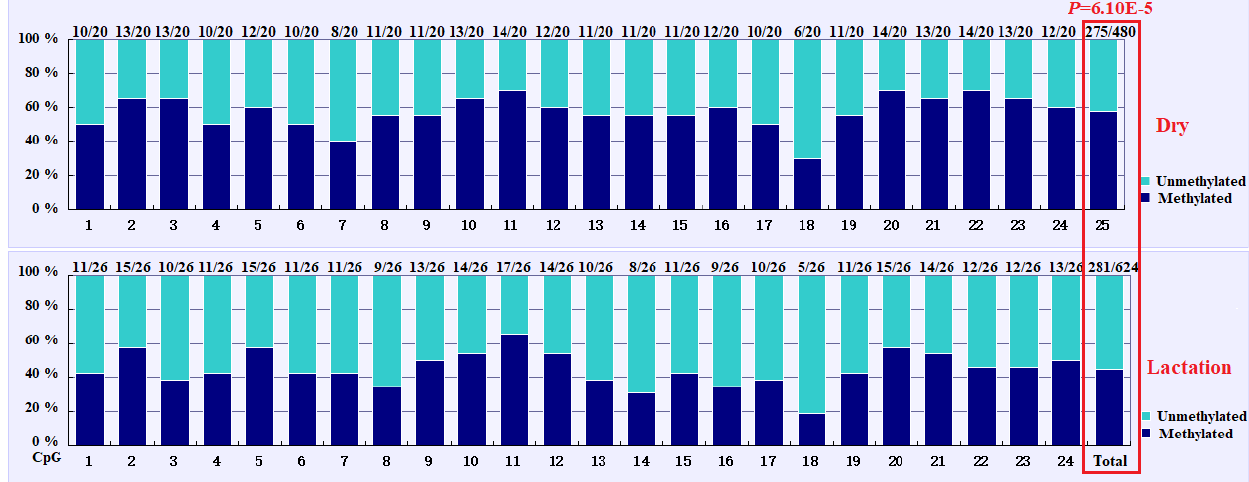
Figure 4. Comparisons of the DNA methylation differences for each CpG locus for mammary gland tissue from dry and lactation periods. The numbers ( X/Y ) above each bar represent the ratio of methylation versus total colonies, and the red frame represents a significant difference.